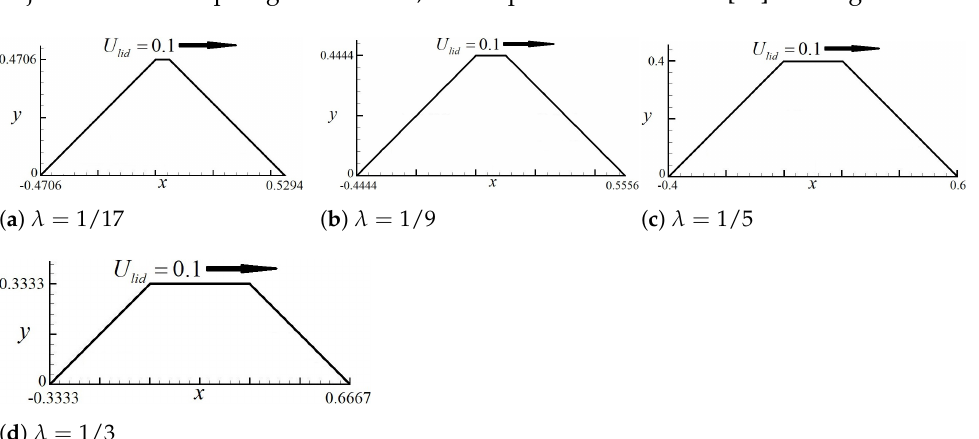
Figure 10. Different geometries of pyramid-shaped right-angled isosceles trapezoidal cavities.